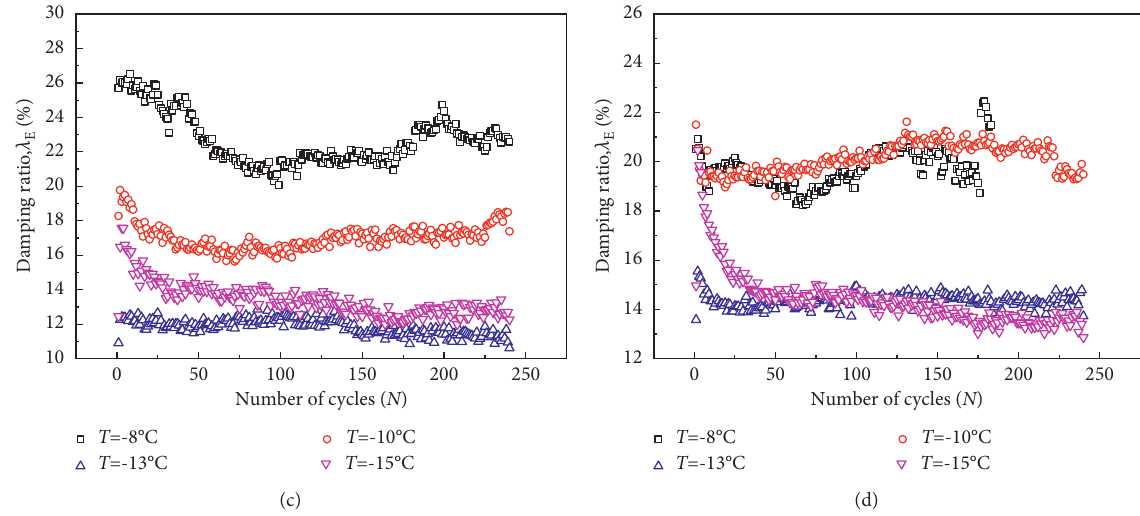
Figure 12: The evolution of the axial damping ratio versus the number of cycles under different temperatures and CSRs. (a) CSR � 0.225. (b) CSR � 0.300. (c) CSR � 0.375. (d) CSR � 0.375.